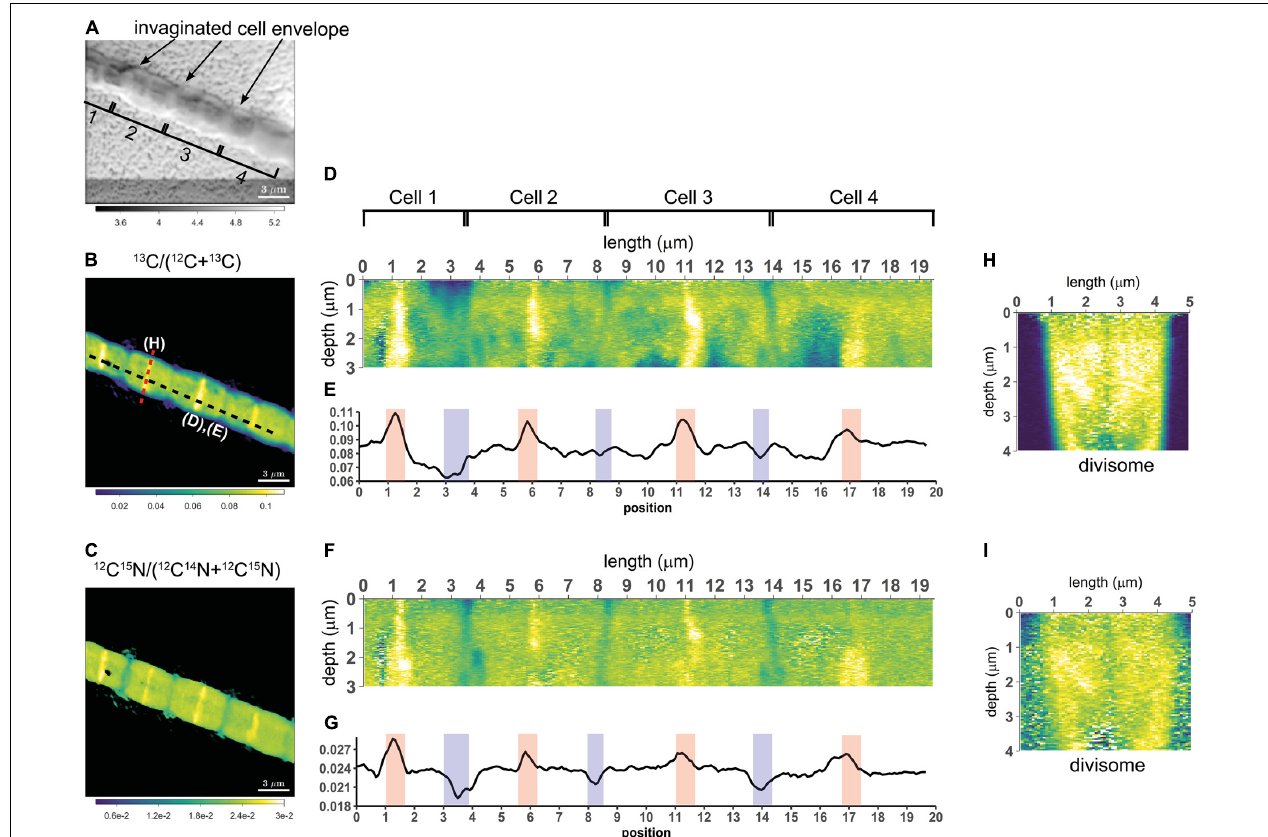
FIGURE 3 | NanoSIMS images of a highly labeled filament in the process of cell division. Measurements were performed on a filament (#20) retrieved from the suboxic zone after labeling with 13 C-bicarbonate and 15 N-ammonium for 24 h. (A) Secondary electron image showing the four cells investigated. The invagination of the cell envelope indicates the cell septa (highlighted by the black arrows). (B) Corresponding nanoSIMS image of the 13 C atom fraction, calculated as 13 C/( 12 C + 13 C). (C) Corresponding nanoSIMS image of the 15 N atom fraction, calculated as 12 C 15 N/( 12 C 14 N + 12 C 15 N). The black dotted line in panel (B) shows where the longitudinal cross-section (D,F) and line analysis (E,G) were performed (19.5 µ m in total). (D,F) The longitudinal cross-sections show the 13 C atom fraction (D) and the 15 N atom fraction (F) as a function of depth. (E,G) The line analysis shows the depth-averaged ratios of the 13 C atom fraction (E) and 15 N atom fraction (G) along the length of four cells. The red and blue areas show the middle of the dividing cell and the cell septa, respectively. (H,I) Transverse cross-section depicting the 13 C atom fraction (H) and the 15 N atom fraction (I) as a function of depth. The cross-section was taken at a division plane [red dotted line in panel (B) ]. Color scales for panel (D,H) are the same as for panel (B) . Color scales for panel (F,I) are the same as for panel (C)